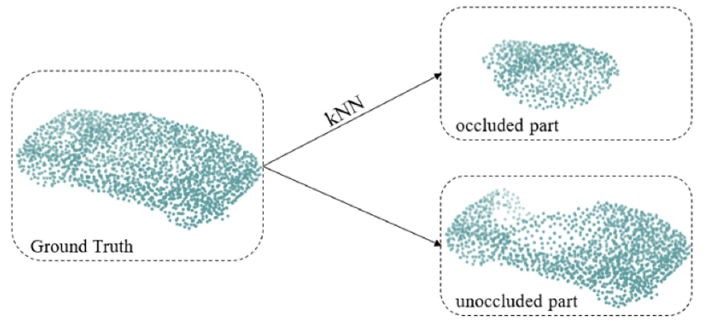
Figure 3. Details of data generation.